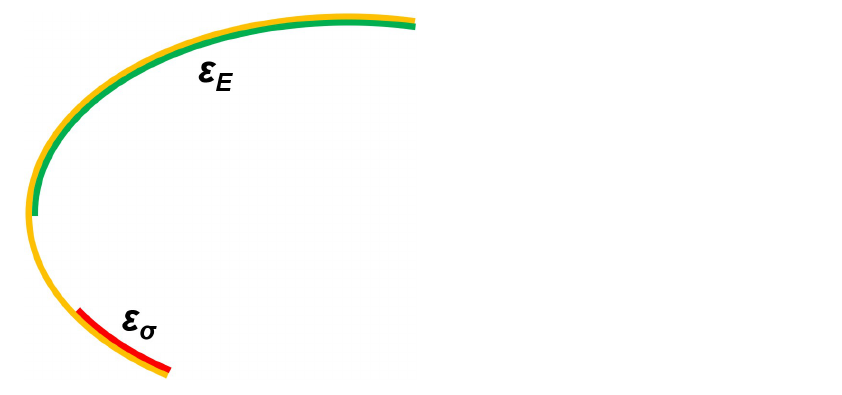
Figure 2. Efficient sets for a risk-neutral DM (green) and risk-averse DM